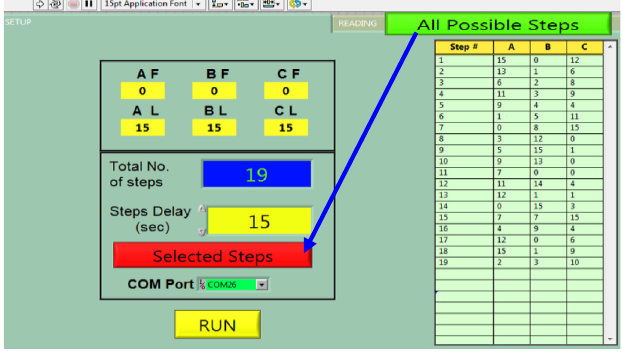
Fig. 3. Front panel of LabVIEW program that controls the capacitance box.